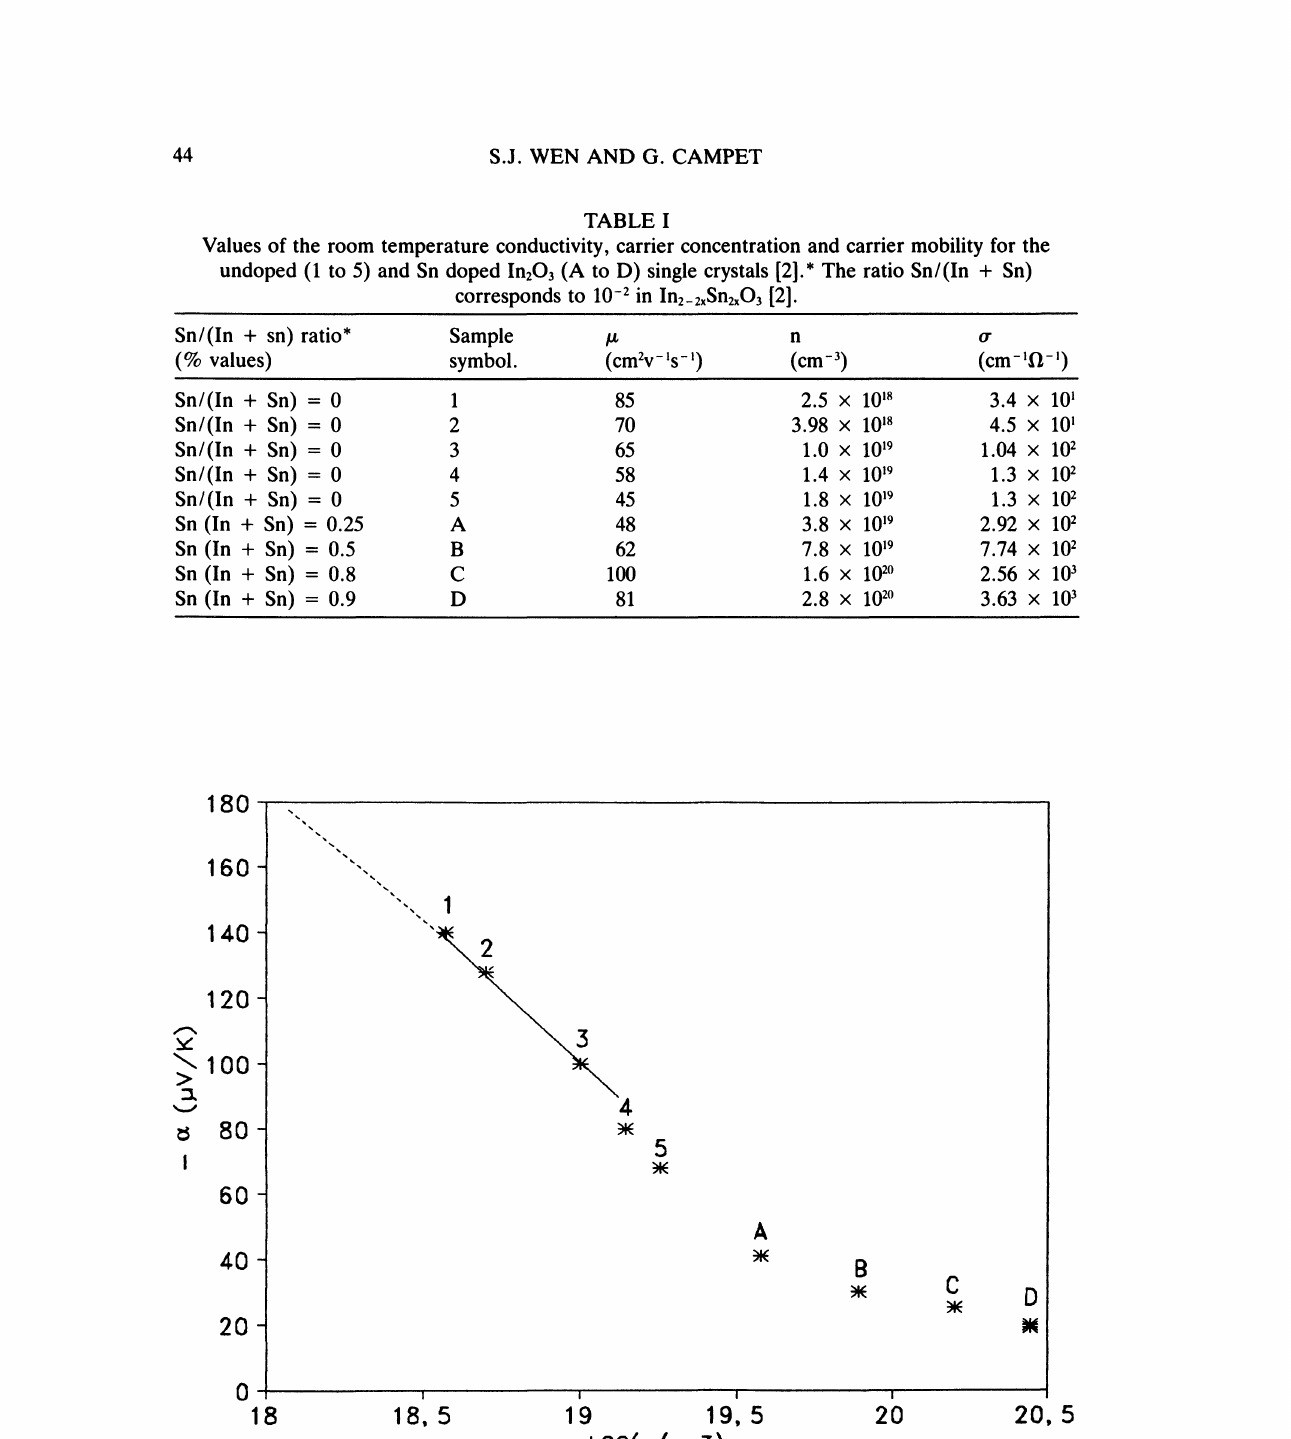
Dependence of the thermoelectric power on the electron density in undoped and Sn doped ln20. single crystals at 300K. The sample symbolization is similar to that depicted in table